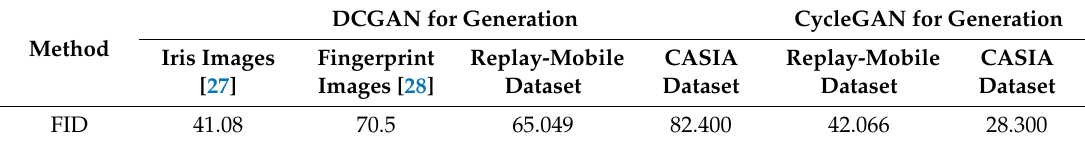
Table 7. Comparison of the measured FIDs in our study with those achieved in previous